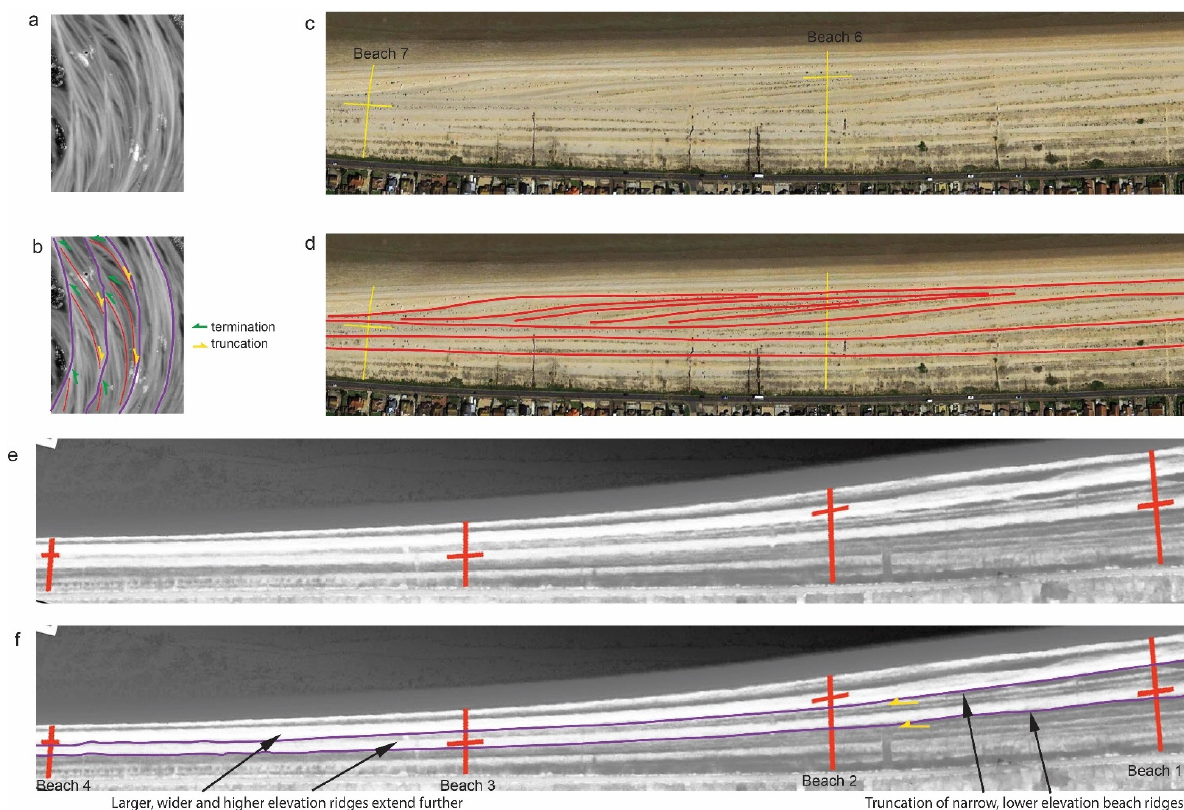
Figure 5. Three patterns of beach ridges that record changes in beach ridge preservation along the coast. Panels ( a , b , e , f ) are lidar images, and panel ( c , d ) is a satellite image from GoogleEarth™. Panels ( b , d , f ) are the same as ( a , c , e ), respectively, with added lines showing interpretation. ( a , b ) Short echelon ridges that overlap and terminate against earlier shorelines at the landward end and are truncated by younger shorelines on their seaward ends; ( c , d ) low-angle sigmoid oblique beach ridges that thin and overlap towards the north in the direction of longshore drift; ( e , f ) truncation of lower elevation and narrower beach ridges by wider, higher elevation beach ridges that extend further along the